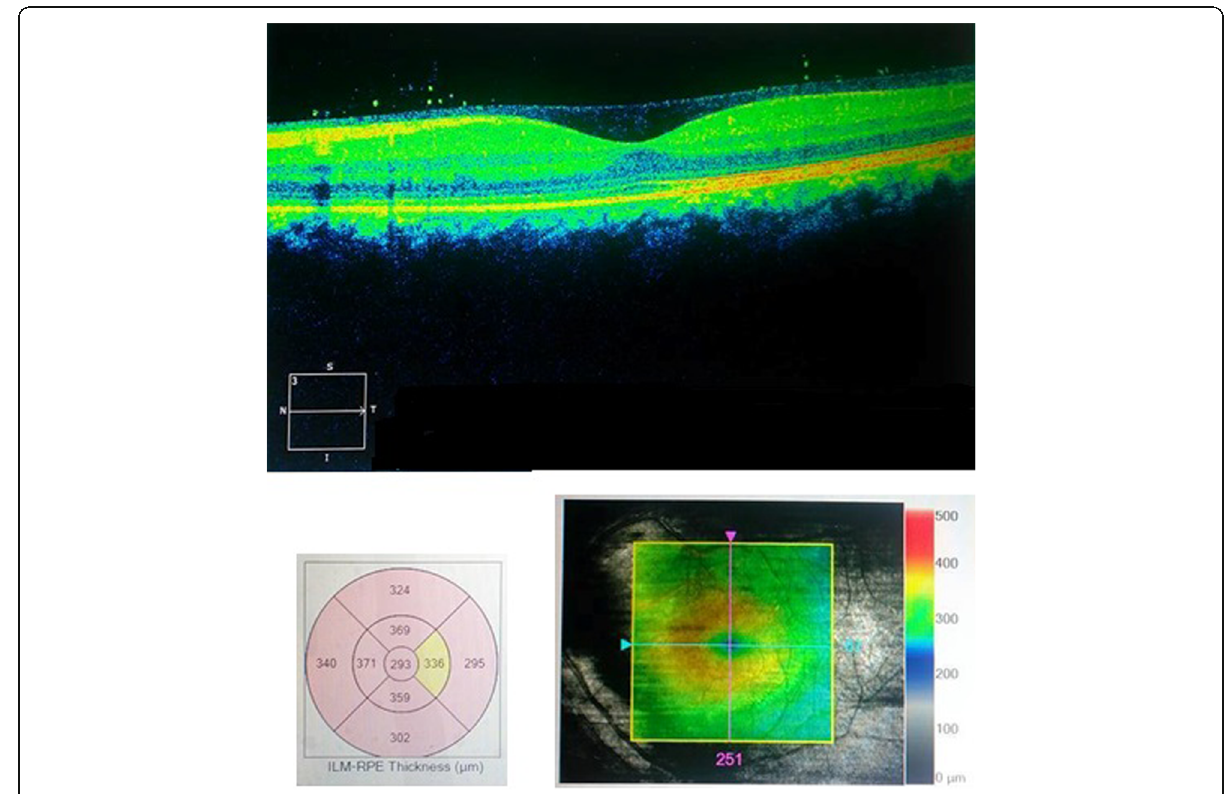
Fig. 8 Day 56 Macular OCT demonstrates generalized macular thickening, preservation of the foveal contour, and prominent posterior hyaloid face detached over the foveal